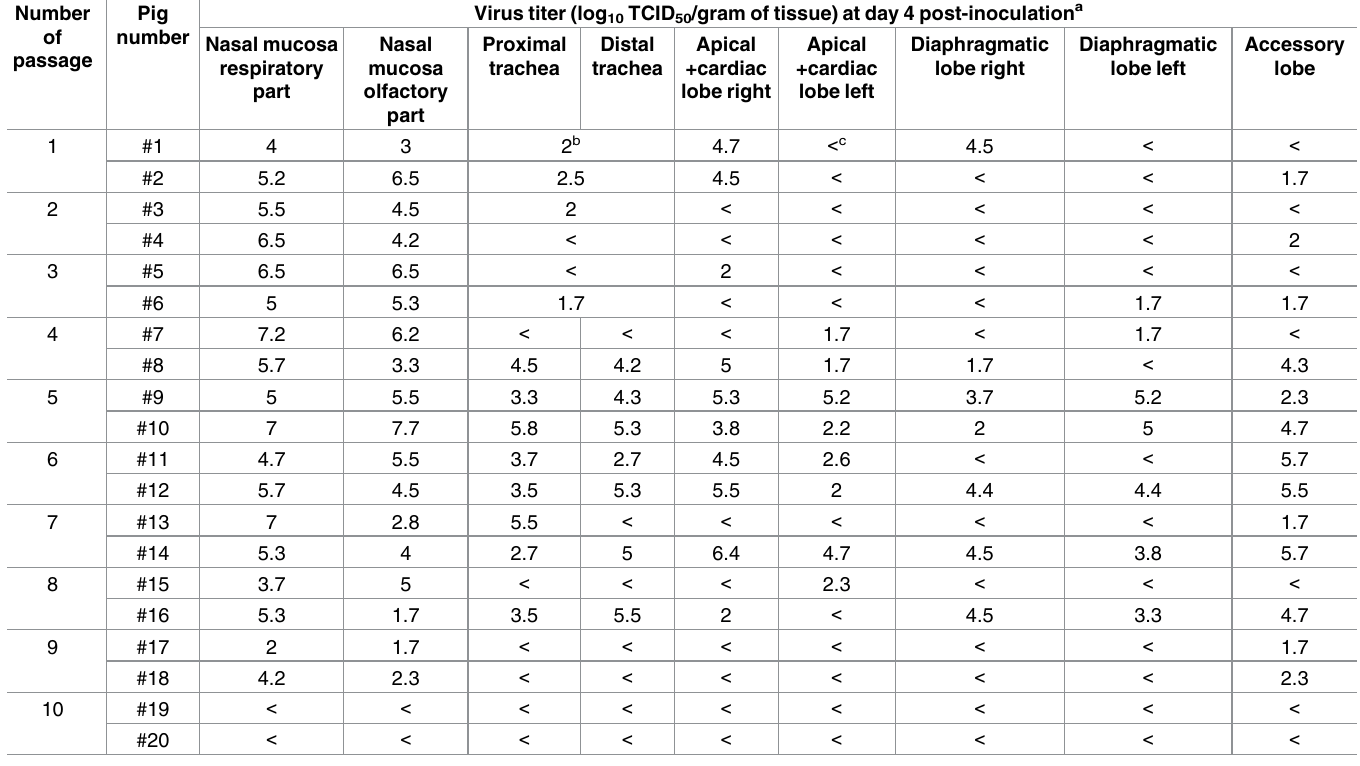
Table 1. Distribution of A/quail/Hong Kong/G1/1997 avian influenza virus in the respiratorytract during ten serial passages in